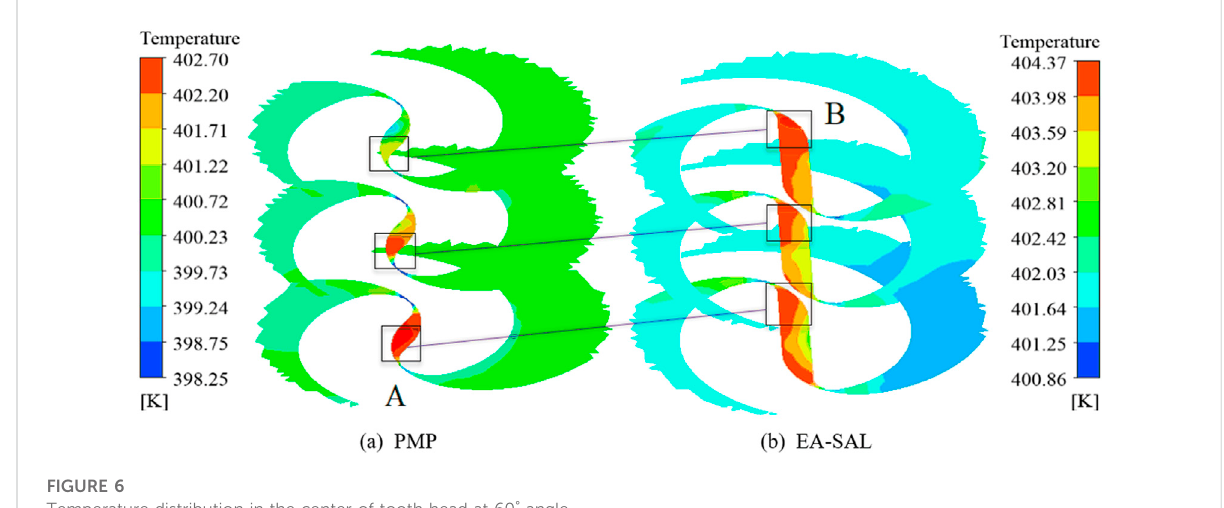
FIGURE 6 Temperature distribution in the center of tooth head at 60 °